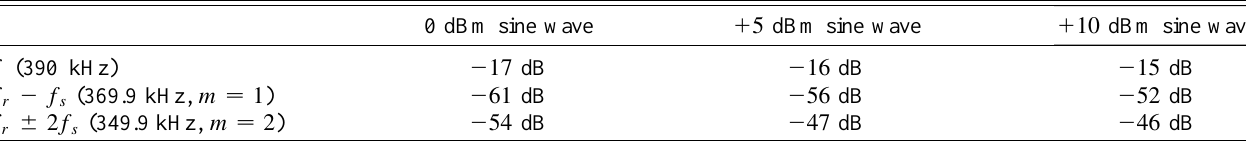
TABLE V. The beam spectra amplitudes from the spectrum analyzer when modulating the amplitude of the rf voltage at 349.9 kHz. 0 dBm sine